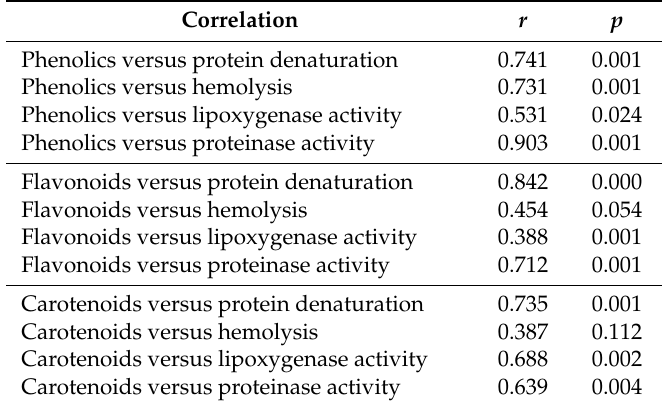
(Table 1). These correlation studies indicate that the evaluated anti-inflammatory properties may be related to the presence of antioxidant bioactives, such as polyphenols, flavonoids, and carotenoids. Table 1. Pearson’s correlation coefficients ( r ) with the level of significance ( p ≤ 0.05) (2-tailed) for flavonoids, carotenoids, and polyphenols, versus anti-inflammatory assays of selected leaf